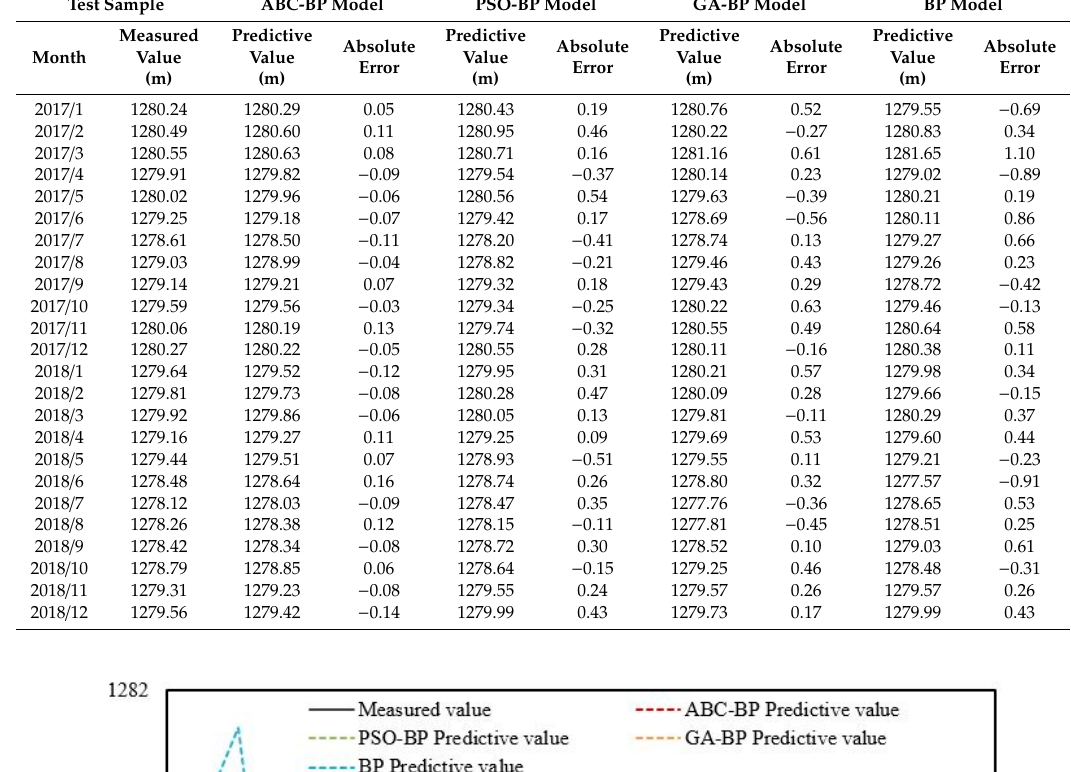
Table 2. Comparison results of groundwater level prediction obtained using the ABC-BP, PSO-BP, GA-BP, and BP models.